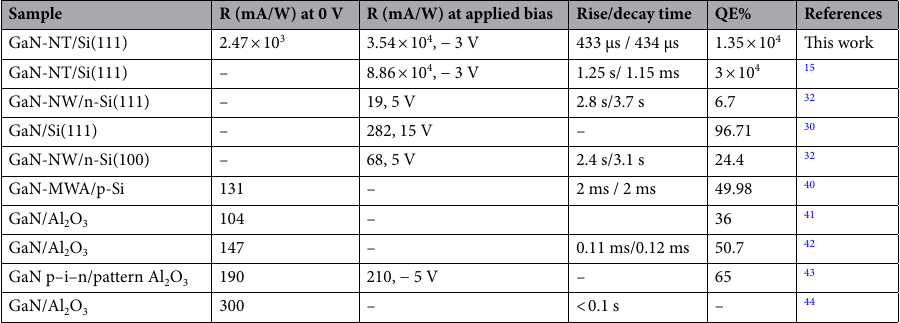
Table 1. Comparison of performance parameters of various GaN-based